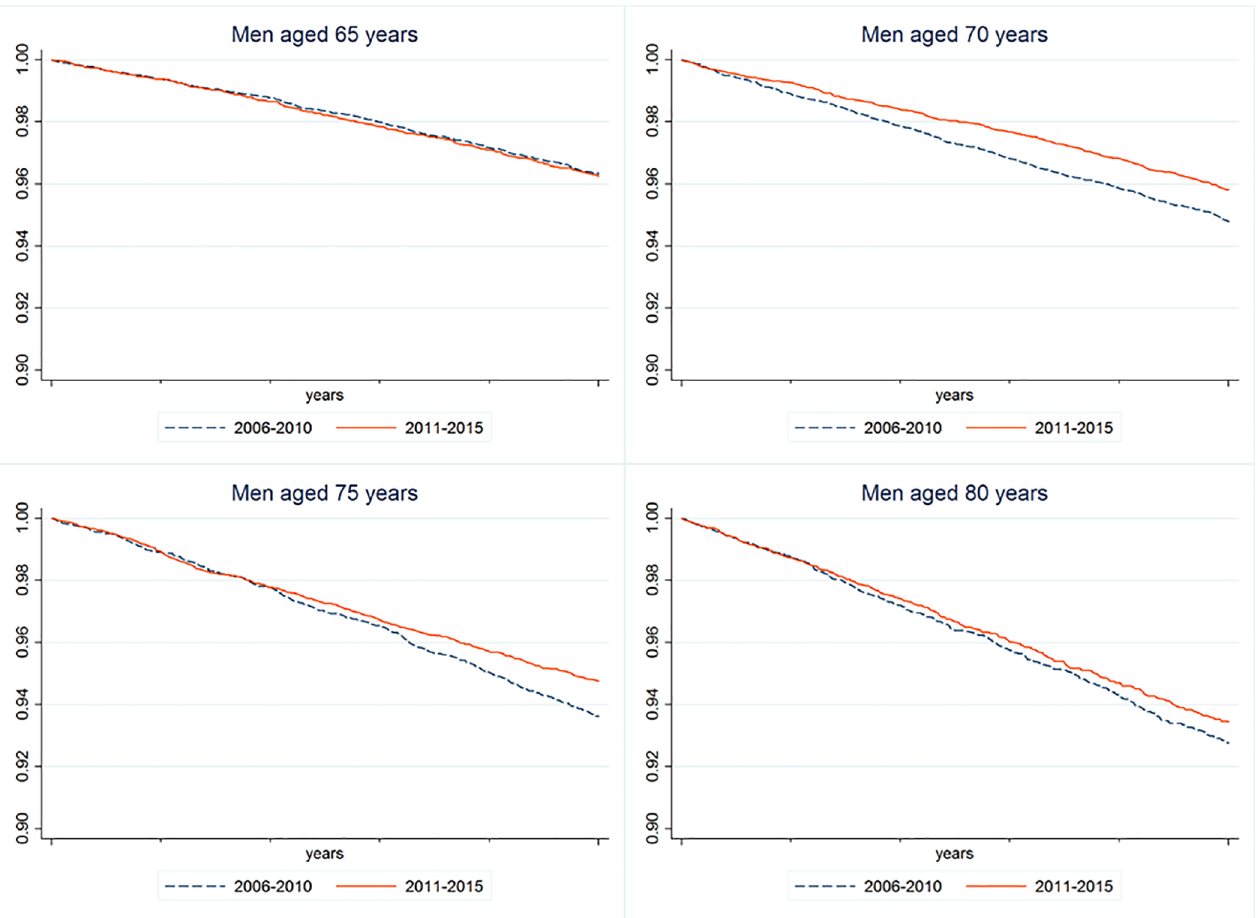
Fig 1. Survival curves of MI-onsets in men of different age groups (65–69 yrs., 70–74 yrs., 75–79 and 80–84 yrs.) over two periods (2006–2010 and 2011–